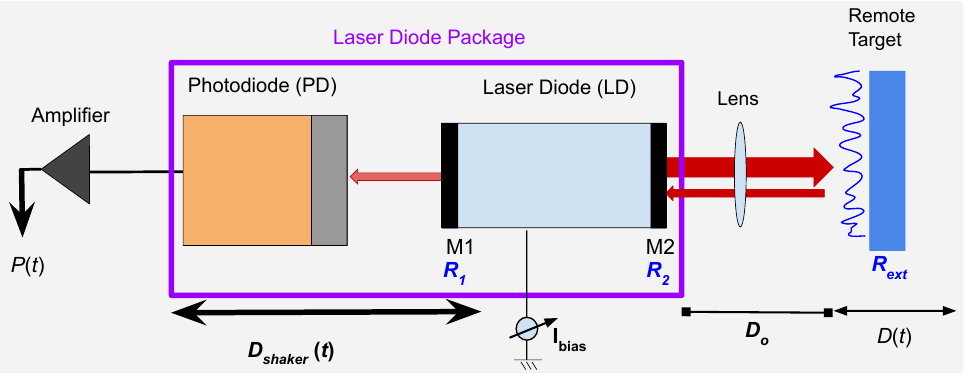
Figure 2. SMI laser sensor is placed at a distance D o from a remote target having surface reflectivity of R ext that is displaced at d ( t ) . M1 and M2 are the LD mirrors having reflectivity of R 1 and R 2 . The electrical signal from the monitor photo-diode is amplified and saved via a data acquisition system. SMI sensor is mounted on a mechanical shaker, vibrating at D shaker ( t ) to facilitate occurrence of